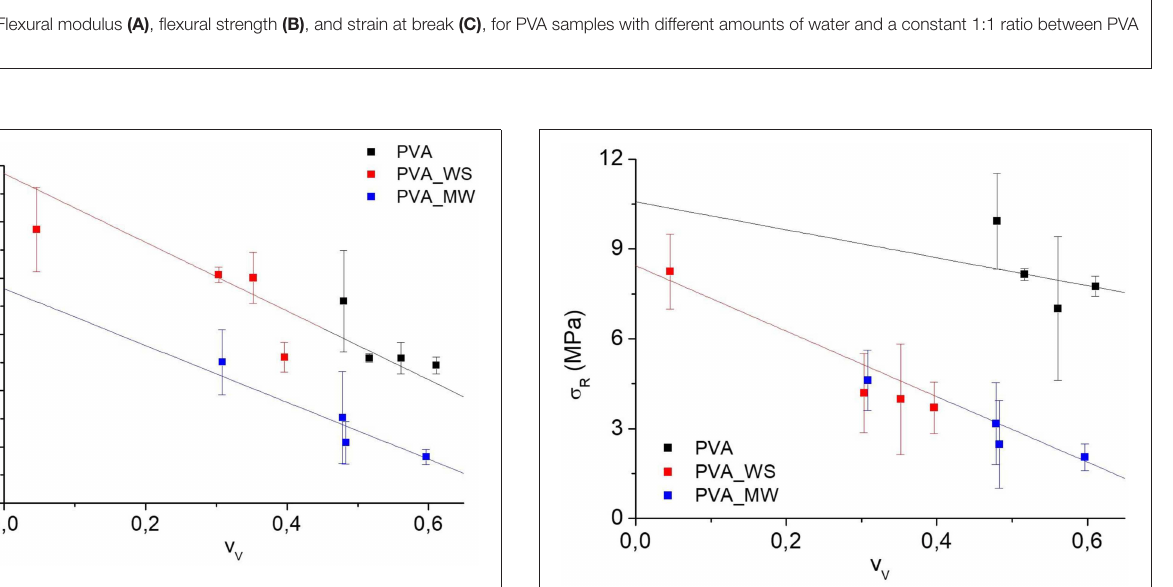
FIGURE 10 | Flexural strength as a function of void